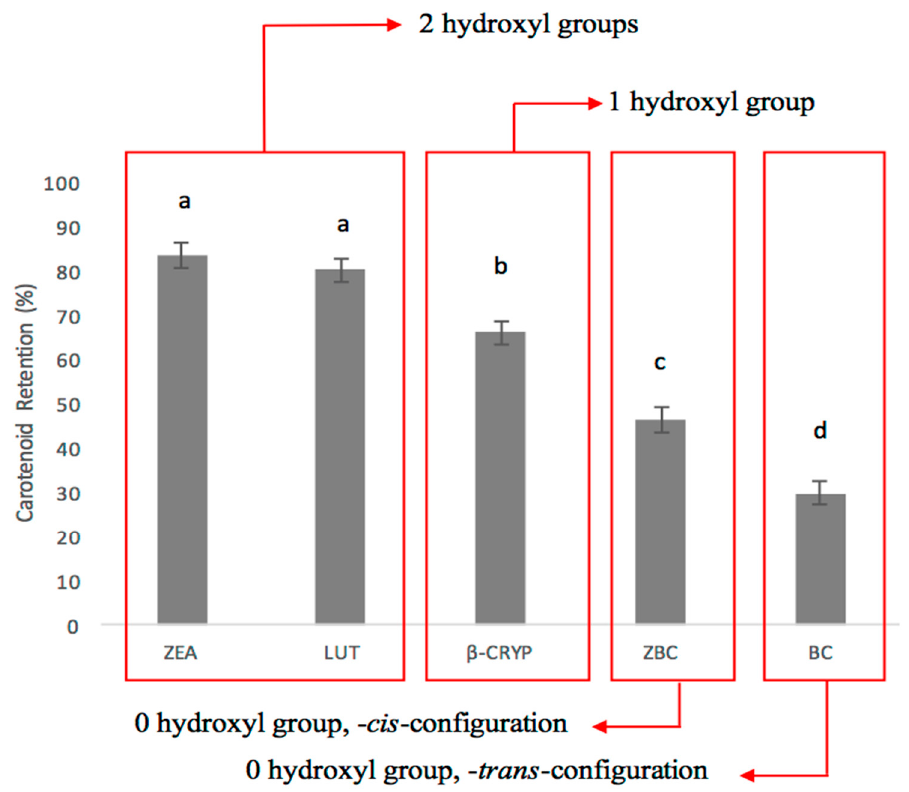
Figure 1. Carotenoids stability during wet cooking of biofortified fermented maize flour. Different letters over the bars indicate significant differences among carotenoids species according to Tukey’s HSD test ( p < 0.05).